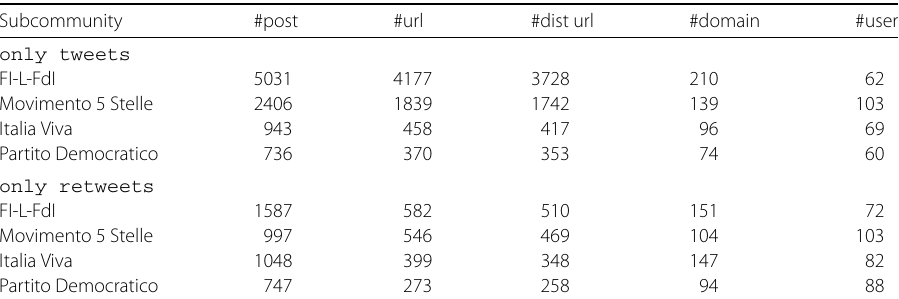
Table 4 Posts, urls, domains and users statistics per political subcommunities – validated network of verified users: #post is the number of posts (divided in tweets and retweets), #url is the number of shared links, #dist url is the number of distinct urls, #domain is the number of distinct domains contained in all urls. While the number of (validated) verified users in the center-right/right wing subcommunity is lower than any other political group, their activity in writing original posts is at least twice greater than any other group. This difference is not present in the number of